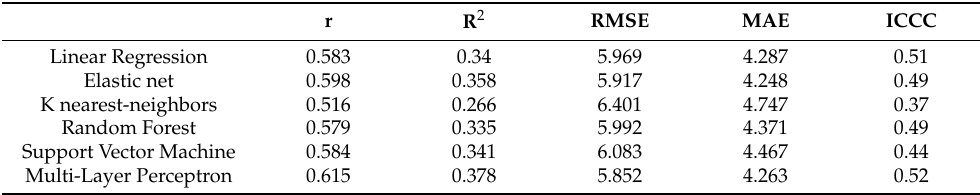
Table 3. Performance of each model in the test dataset.